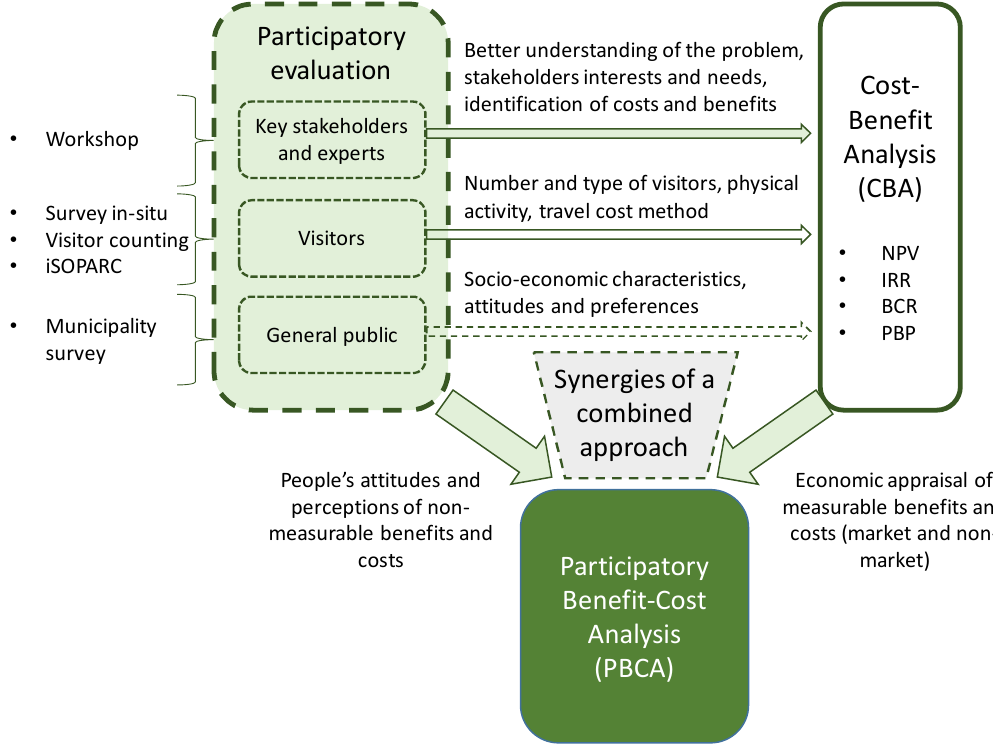
Figure 1. Conceptual framework to evaluate the Thinking Fadura project based on Participatory Cost Benefit Analysis. iSOPARC: System for Observing Play and Active Recreation in Communities; NPV: Net Present Value; IRR: Internal Rate of Return; BCR: Benefit-Cost Ratio; PBP: Payback Period.